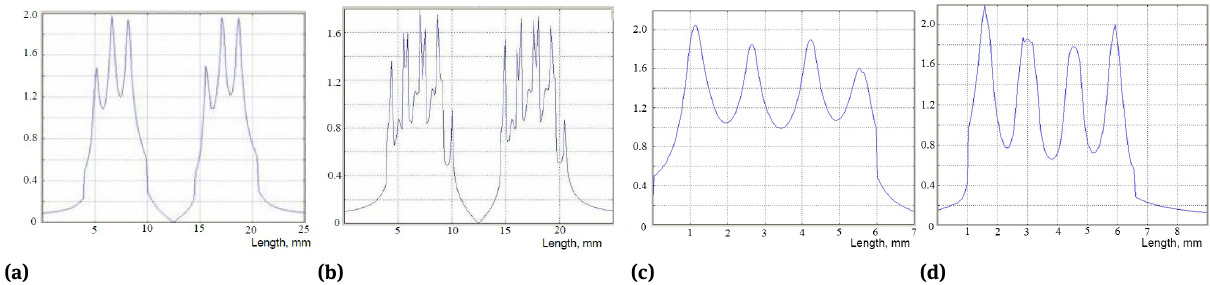
Figure 2: The distribution of the module of the magnetic induction vector | B | under one pole of the sealer along the midline in the gap: a) – with teeth on the magnetic circuit; b) – with teeth on the magnetic circuit of trapezoidal form and “inner” teeth of rectangular form on the shaft; c) – with “inner” teeth of trapezoidal form on the shaft; d) – with “inner” teeth of cylindrical form on the shaft.